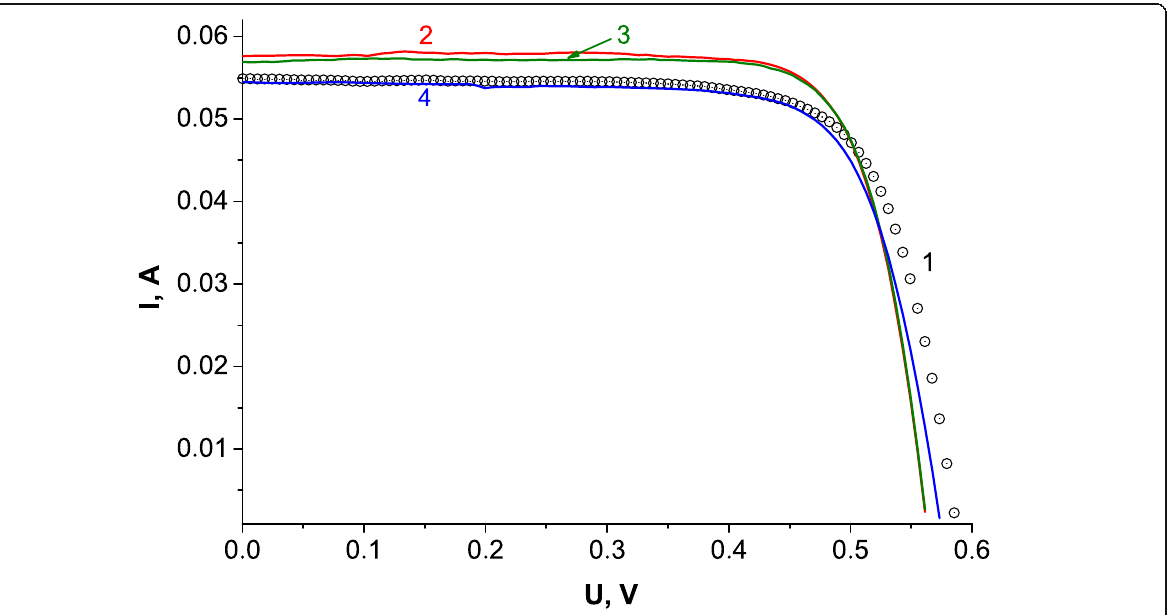
Fig. 1 AM1.5 IU characteristics of Si-based SCs in general configuration under RF treatments (13.56 MHz stimulated discharge H + plasma, t =15 min, P =0.8 W/cm 2 ) with the following intensity values: 1 initial, 2 95 W, 3 225 W, 3 225 W, and 4 300